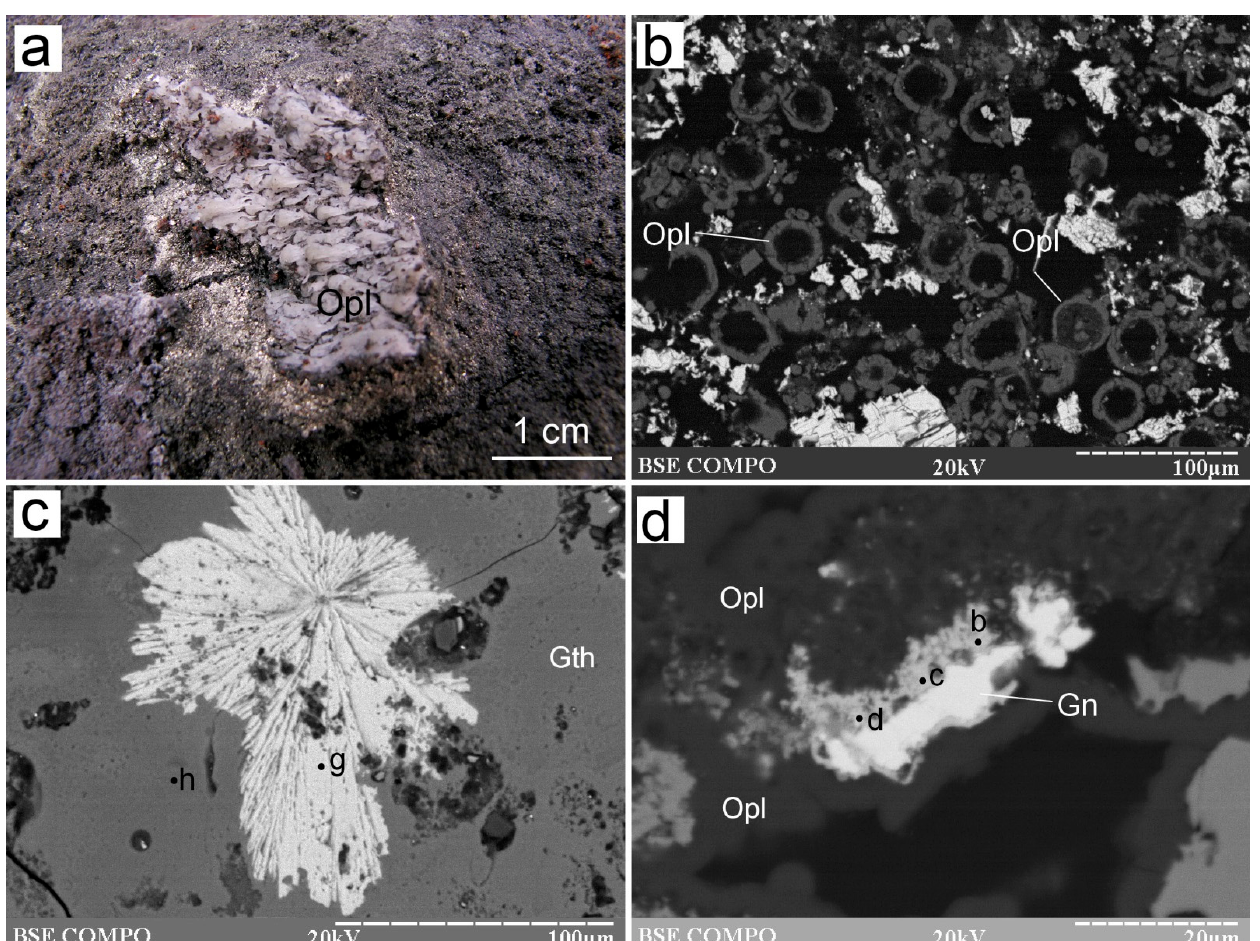
Figure 10. Morphology of some non-sulfide minerals from the Irinovskoe HSF: ( a ) Opal sinters in a channel of a Zn-rich chimney; ( b ) Opal “donuts” on sulfides; ( c ) Radial baryte aggregate (point g) in Fe-oxyhydroxides (point h); ( d ) Galena grains replaced by anglesite (points b–d). On-board photo ( a ), BSE images ( b–d ). Samples: 241-2/3-2 ( b ), 241-2/2-5 ( c ), 241-2/2-2 ( d ).